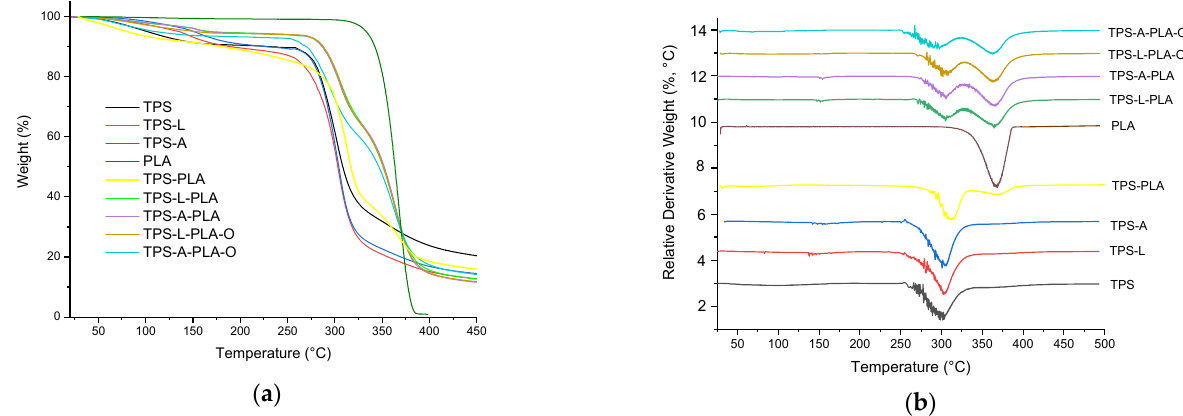
Figure 5. Thermogravimetric analysis (TGA) ( a ) and derivative thermogravimetry (DTG) ( b ) curves for TPS samples.